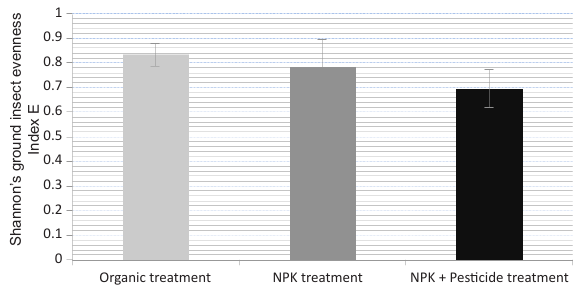
Figure 3. Bar plot for ground insect shows mean Shannon’s species evenness index (E) for all treatments with their 95% confidence intervals